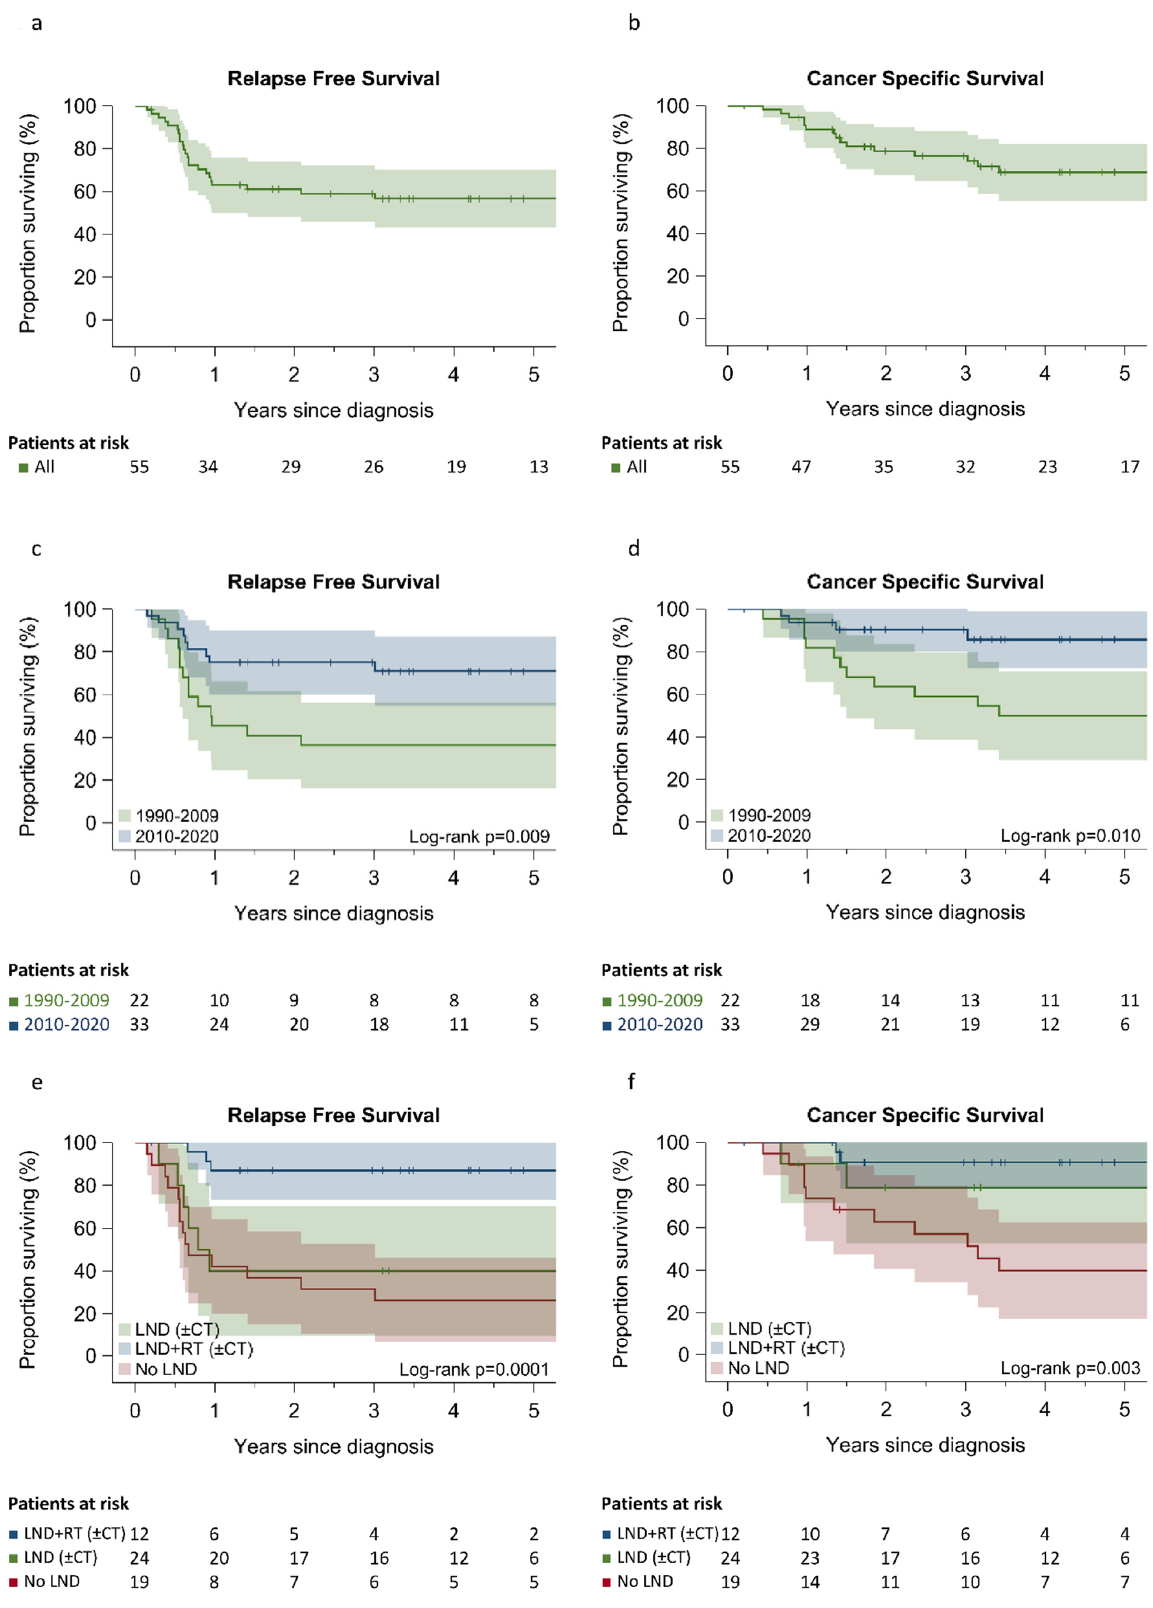
Figure 1. Relapse free survival and cancer–specific survival for all patients ( a , b ), by time period ( c , d ) and according to treatment modality ( e , f ). LND: lymph node dissection; RT: radiotherapy; ChT: chemotherapy.